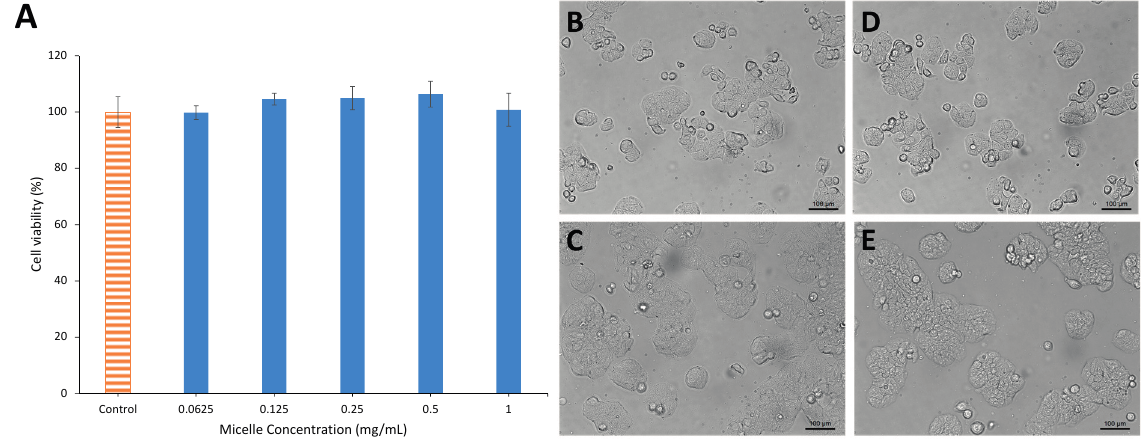
Figure 6. Viability and morphology of HT29 colorectal cancer cells challenged with GCV-PCL-chitosan polymeric micelles at different dosages ranging from 0–1 mg/mL. ( A ) Viability of HT29 cells after 48 h treatment determined by MTT assay; ( B ) untreated cells, 0 h; ( C ) micelle treated cells, 0 h; ( D ) untreated cells, 48 h; ( E ) micelle treated cells, 48